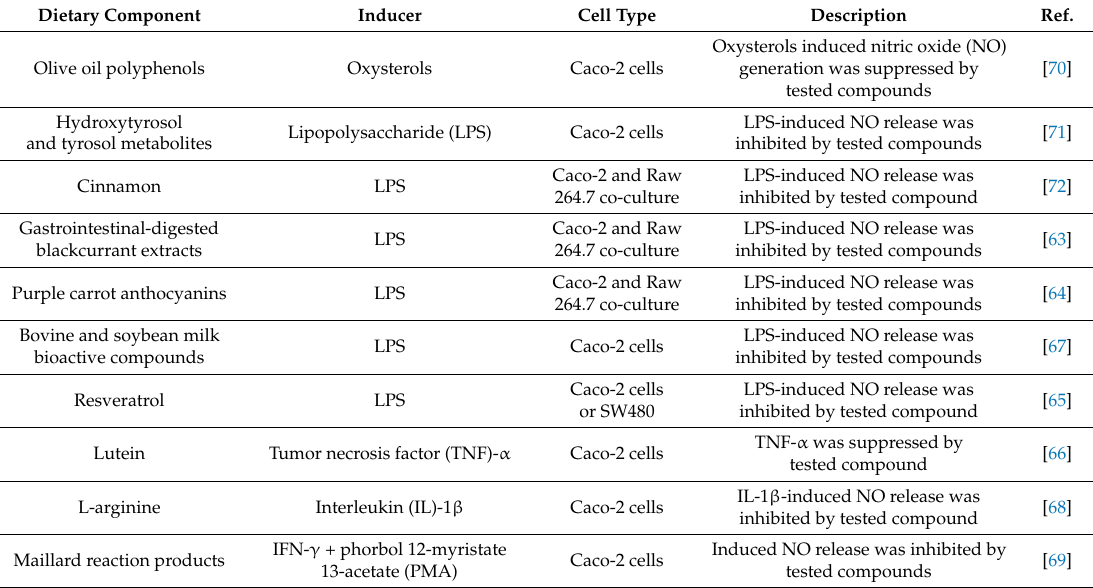
Table 1. Effect of dietary component on nitric oxide production in intestinal epithelial